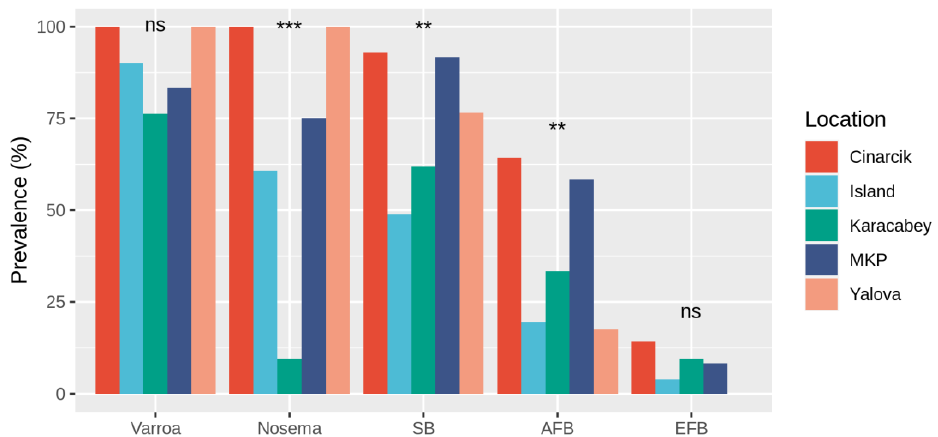
Figure 1. The prevalence of Varroa mites (Varroa), Nosema ceranae (Nosema), stonebrood (SB), American foulbrood (AFB), and European foulbrood (EFB) in terms of a percentage found at a colony level. Each color represents a different sampling apiary location within the Marmara region of Turkey. Statistical significance was determined using Fisher’s exact test. *** p ≤ 0.001, ** p ≤ 0.01, not significant (ns) p >